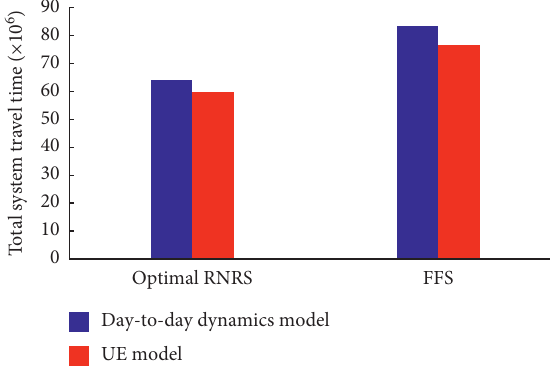
Figure 11: Total system travel time under a day-to-day dynamics model and UE model.